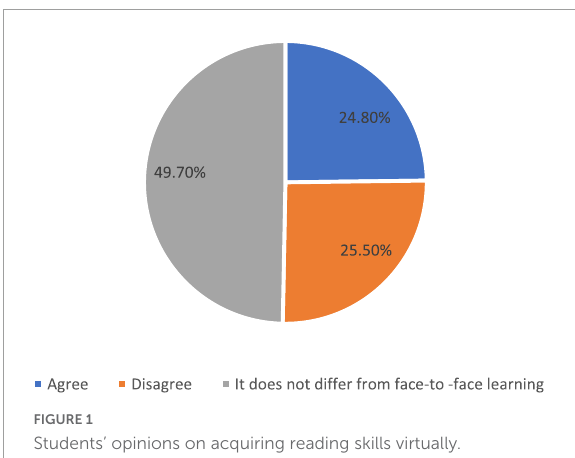
FIGURE1 Students’ opinions on acquiring reading skills virtually.